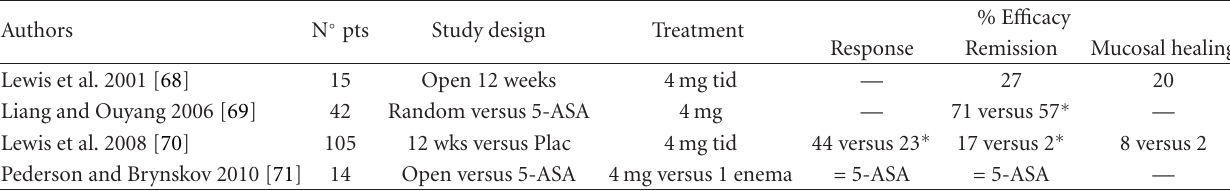
Table 3: E ffi cacy of rosiglitazone therapy in ulcerative colitis ( ∗ P values <